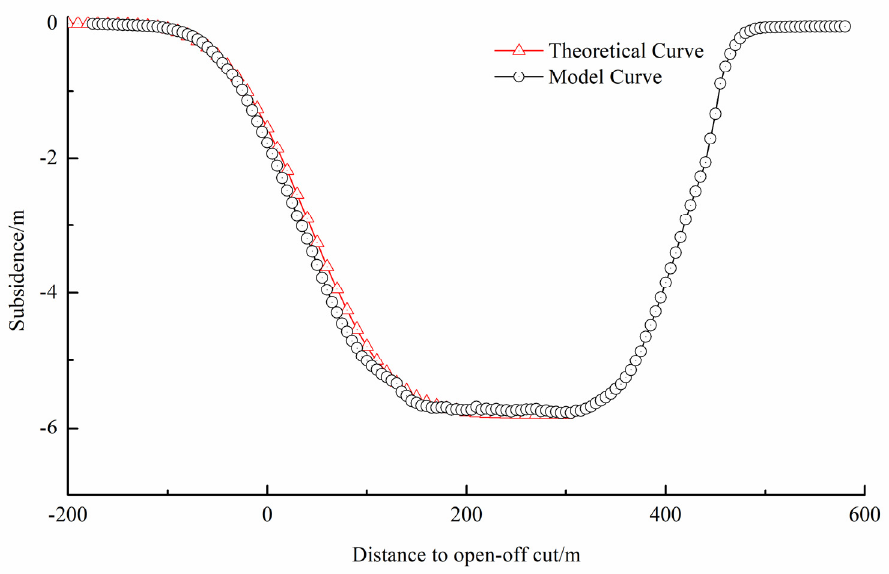
Figure 7. Contrast subsidence curves between the survey data and the numerical model.